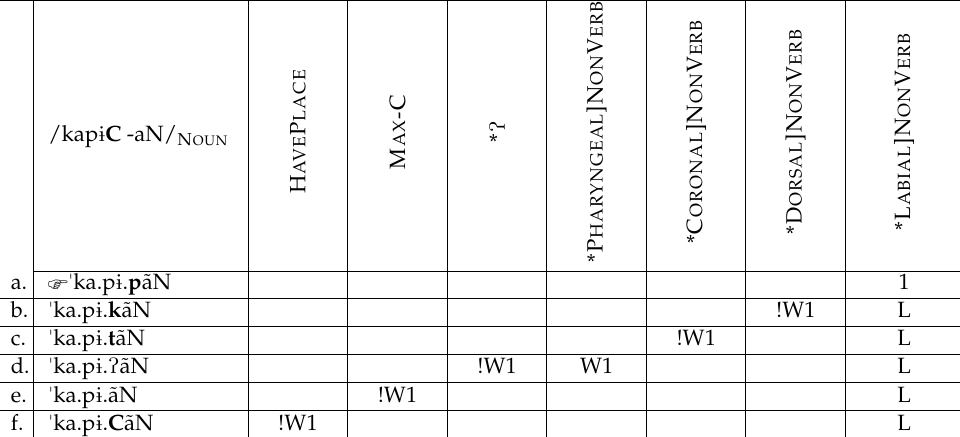
Table 3. /kap ɨ C -aN/ → [ ˈ ka.p ɨ . k ãN] ‘alligator’ (/-N/form)—Shipibo-Konibo.